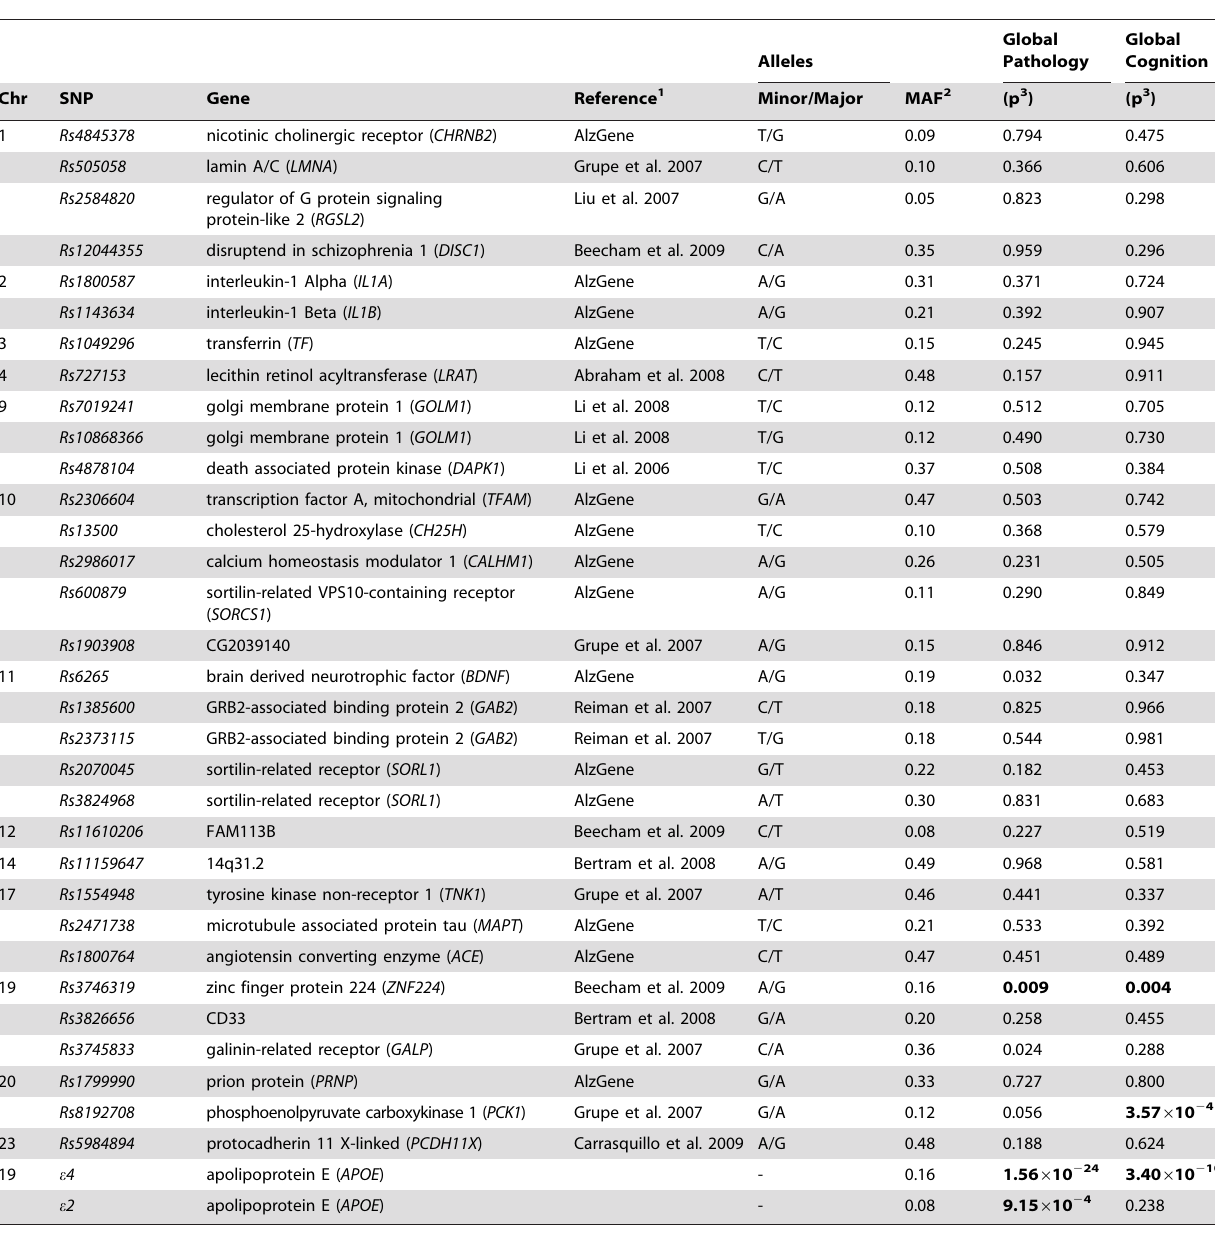
Table 2. Relation of candidate AD polymorphisms to intermediate cognitive and pathologic phenotypes.